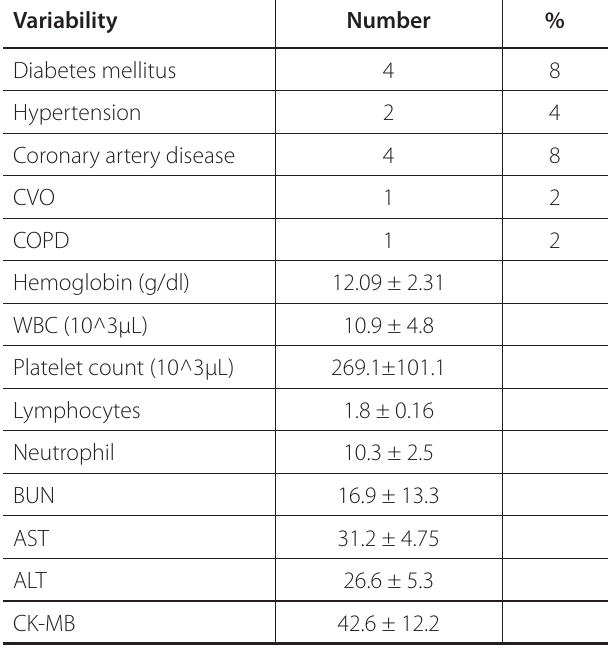
Table 1 . Patients’ baseline